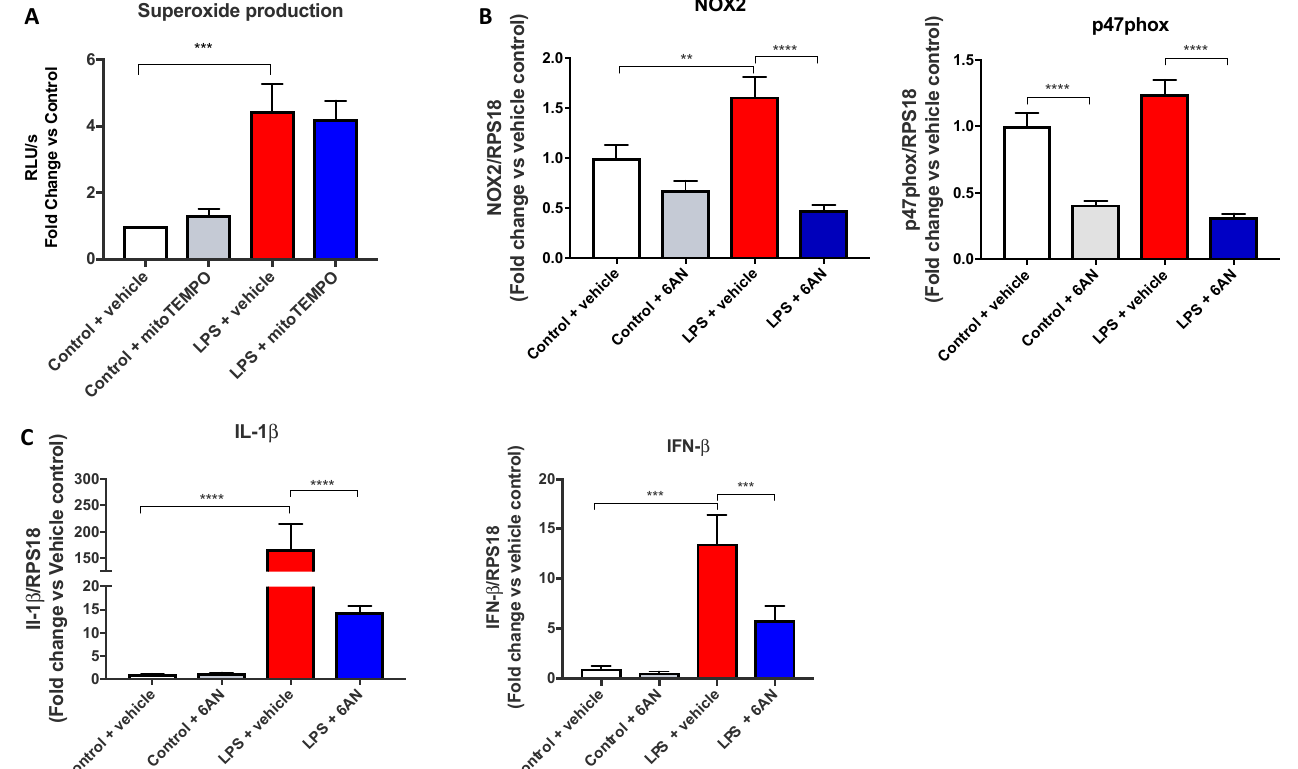
Figure 4. The pentose phosphate pathway is a regulator of NOX2 activity and expression and of inflammation. ( A ) Oxidative burst measured by L-012-enhanced chemiluminescence in RAW 264.7 macrophages, ( B , C ) mRNA expression measured using qPCR. Cells were co-treated with 6-AN (200 μ M) and LPS (100 ng/mL) for 24 h. Data are presented as mean ± SEM of n = 8–9 experiments. Data is expressed as ( A ) a fold change against the respective control in relative light units (RLU), measured as an average of triplicates over a 60-cycle period, subtracted by blank readings or the fold change against the vehicle control of a peak response over an average of triplicates over the 60-cycle period, subtracted by blank readings, or ( B , C ) fold change vs. control against the housekeeping gene RPS18. Statistical analysis was conducted via a one-way ANOVA followed by Tukey’s post hoc test for multiple comparisons. ** indicates p < 0.01, *** indicates p < 0.001 and **** indicates p < 0.0001.